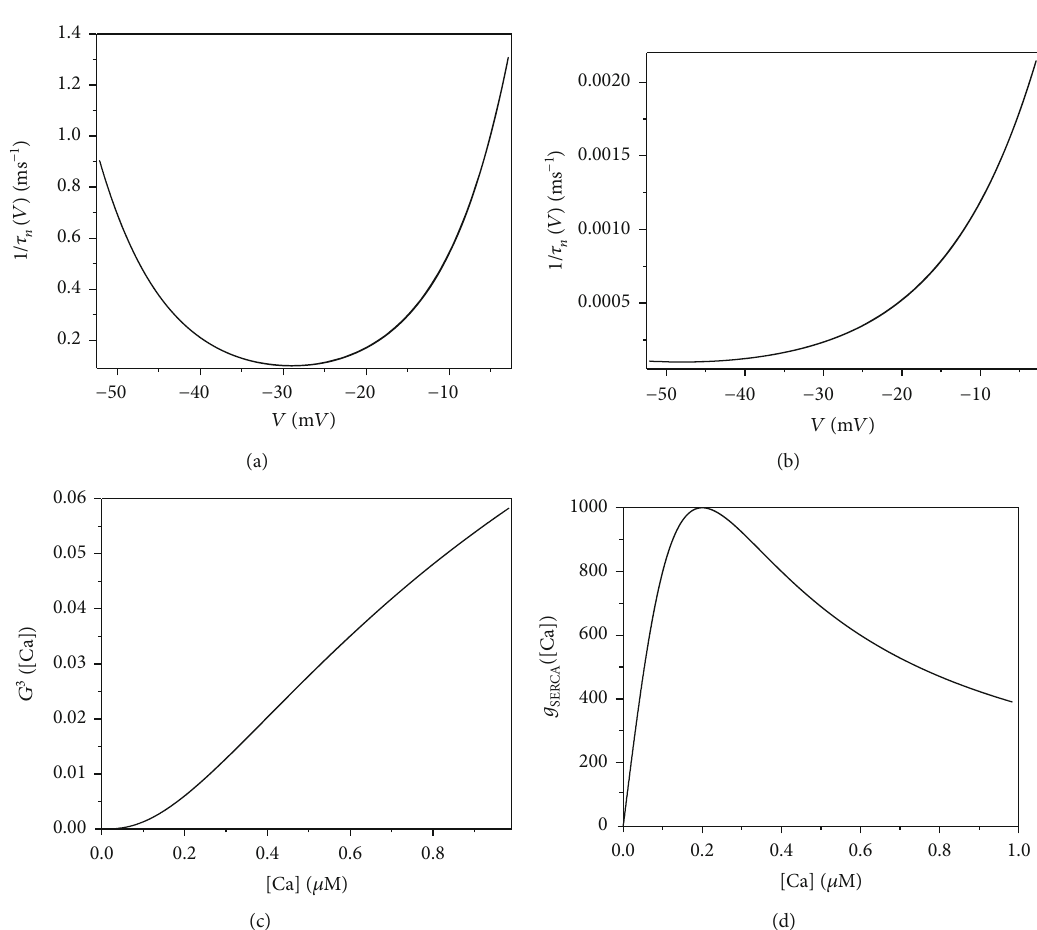
Figure 1: Change of functions of (a) 1/ τ ð½ Ca (cid:2)Þ with ½ Ca (cid:2) . and (d) g SERCA